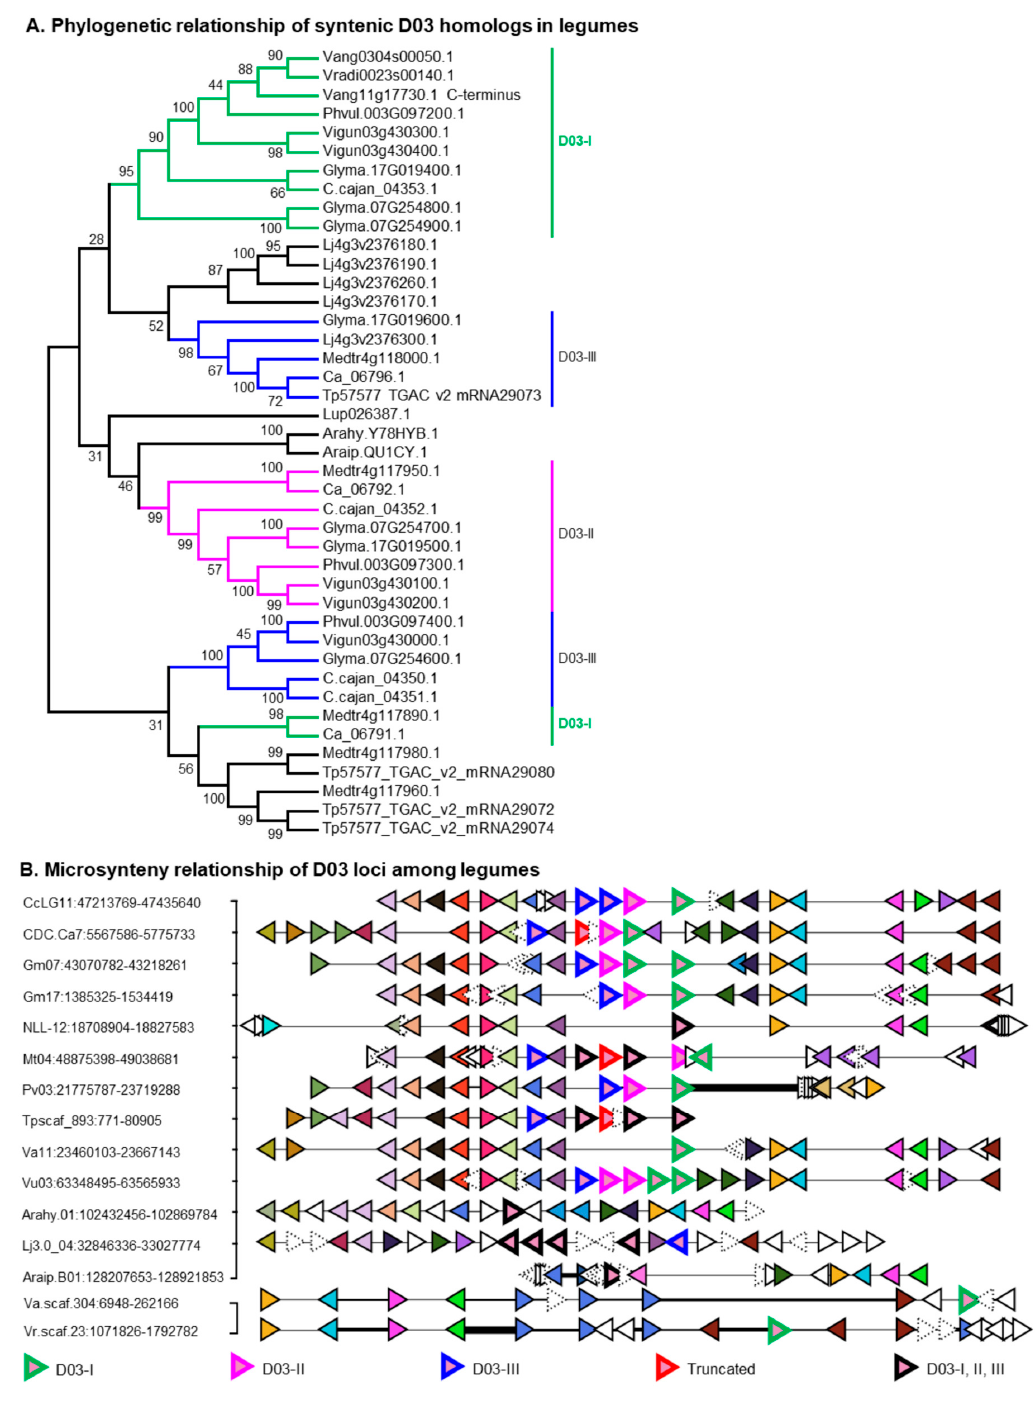
Figure 3. Evolutionary history of putative ortholog locus (POL) D03 in legumes. ( A ). Phylogenetic F3 relationship of syntenic D03 homologs in 14 legumes. The full-length sequence of Vang11g17730.1 (1283 amino acids length) could be a sequencing error; only its C-terminus (471 amino acids) shared high amino acid percent identity with D03 members. Based on amino acid percent identity, D03